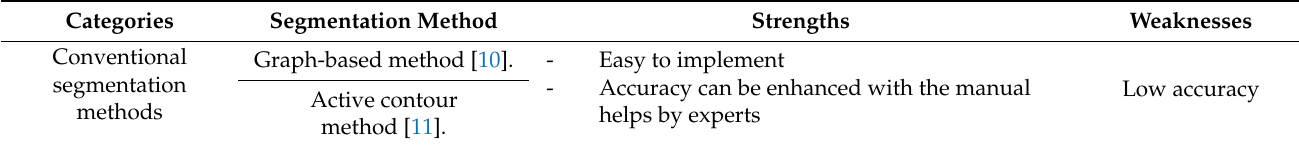
Table 1. Summary of medical image segmentation method in previous studies and our